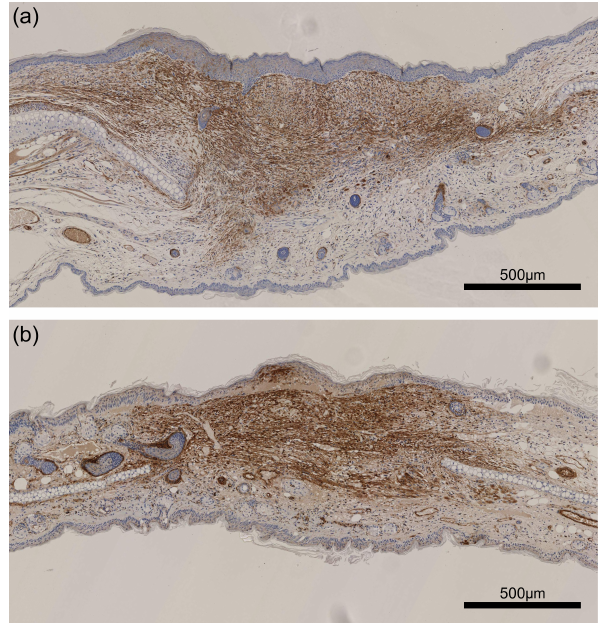
Figure 8. α -Smooth muscle actin staining of the cutaneous wound model in the mouse pinna. Positive staining in ( a ) non-diabetic and ( b ) diabetic mouse indicates smooth muscles cells demonstrating that wound closure was promoted by